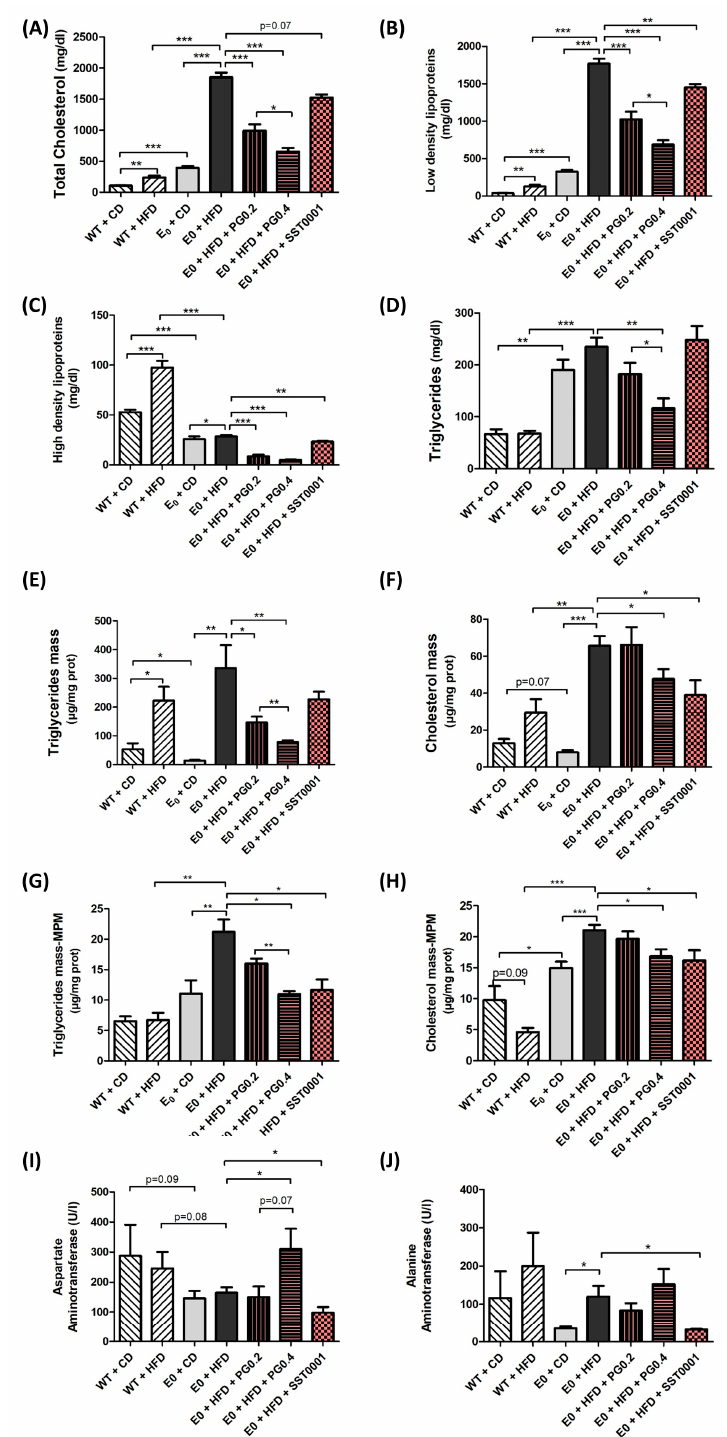
Figure 4. Effect of heparanase inhibitors on lipid uptake in macrophages. Cholesterol, LDL-C, HDL-C, and TG serum levels ( A – D ), TG and cholesterol content in the liver ( E , F ), TG and cholesterol in MPMs in vivo ( G , H ), and liver enzymes in serum ( I , J ). * p < 0.05, ** p < 0.01 and *** p < 0.001. Fat content in the treated groups was comparable to the E 0 -CD